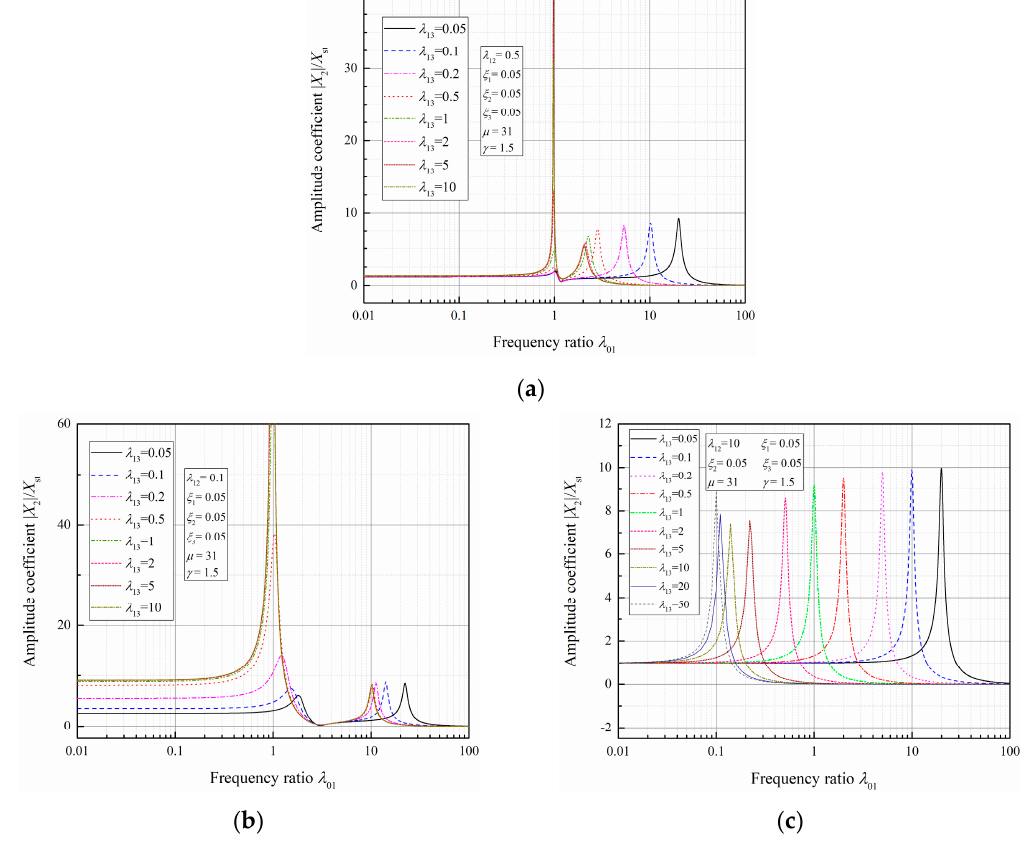
Figure 12. The dynamic response of the accessory structure with varying parameter λ 13 . ( a ) λ 12 = 0.5; ( b ) λ 12 = 0.1; ( c ) λ 12 = 12